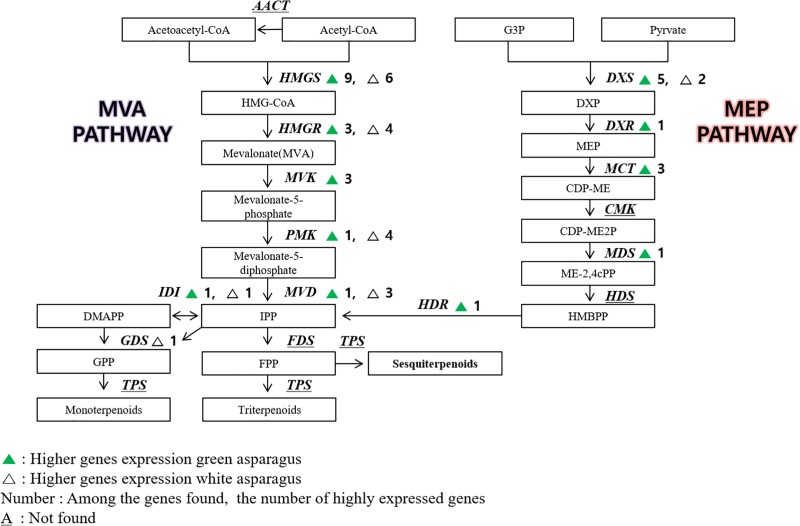
Biosynthetic pathways and compartmentalization of terpenoid synthesis in plants.AACT, acetoacetyl-CoA thiolase; AcAc-CoA, acetoacetyl-CoA; CDP-ME, 4-(cytidine 5′-diphospho)-2-C-methyl-d-erythritol; CDP-ME2P, 4-(cytidine 5′-diphospho)-2-C-methyl-d-erythritol phosphate; CMK, CDP-ME kinase; DMAPP, dimethylallyl diphosphate; DXP, 1-deoxy-d-xylulose 5-phosphate; DXR, DXP reductoisomerase; DXS, DXP synthase; FDS, farnesyl diphosphate synthase; FPP, farnesyl diphosphate; G3P, glyceraldehyde-3-phosphate; GDS, geranyl diphosphate synthase; GPP, geranyl diphosphate; HDR, (E)-4-hydroxy-3-methylbut-2-enyl diphosphate reductase; HDS, (E)-4-hydroxy-3-methylbut-2-enyl diphosphate synthase; HMBPP, (E)-4-hydroxy-3-methylbut-2-enyl diphosphate; HMG-CoA, 3-hydroxy-3-methylglutaryl-CoA; HMGR, HMG-CoA reductase; HMGS, HMG-CoA synthase; IDI, isopentenyl diphosphate isomerase; IPP, isopentenyl diphosphate; ISPS, isoprene synthase; MCT, 2-C-methyl-d-erythritol 4-phosphate cytidylyltransferase; MDS, 2-C-methyl-d-erythritol 2,4-cyclodiphosphate synthase; ME-2,4cPP, 2-C-methyl-d-erythritol 2,4-cyclodiphosphate; MEP, 2-C-methyl-d-erythritol 4-phosphate; MVD, mevalonate diphosphate decarboxylase; MVK, mevalonate kinase; PMK, phosphomevalonate kinase; TPS, terpene synthase. Enzyme names are in italics.